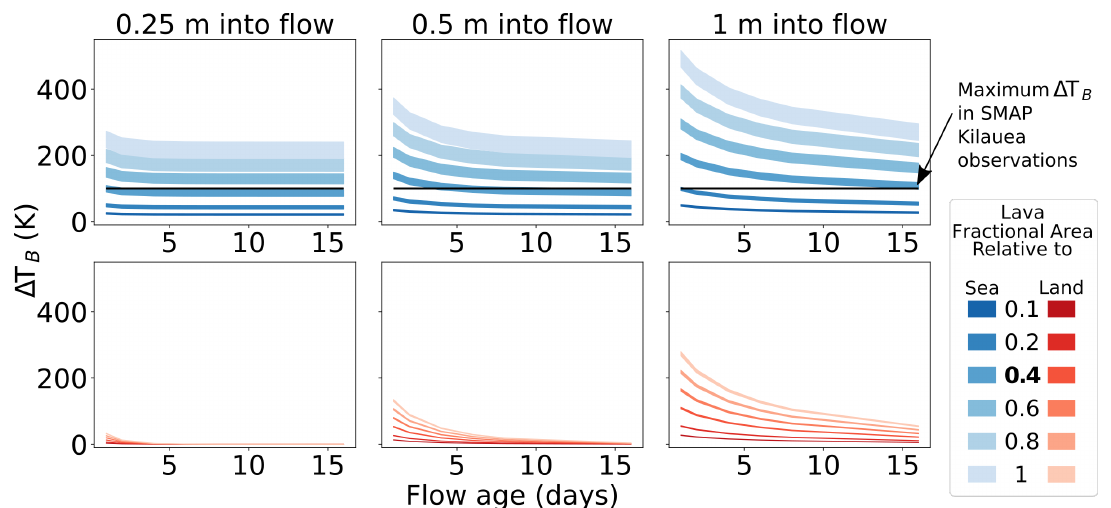
Figure 7. Change in brightness temperature for cooling lava flows as a function of fractional area in a footprint where the surrounding is sea (blues) or land (reds). Line thickness represents the range of possible differences between a lava flow and typical brightness values for sea and land (50–100 K and 280–320 K) in SMAP data. The 0.4 fractional area curves represent the maximum extent of the Kilauea flow